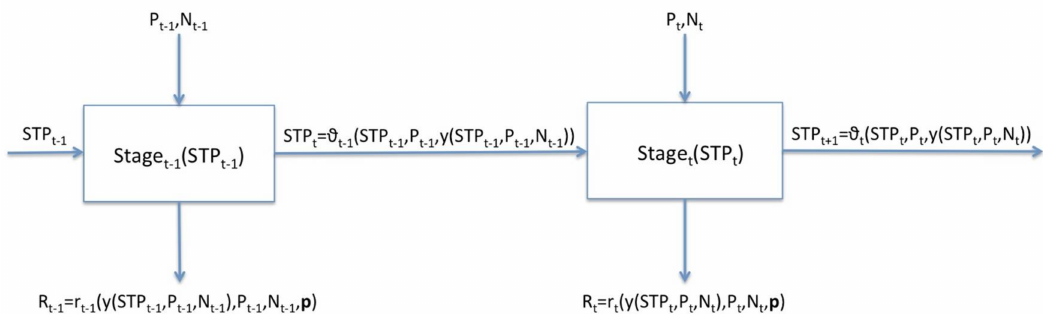
Figure 2. The conceptual farm-level dynamic decision model (adapted from Hardaker et al. [49]), where t denotes a stage (one year), STP is the soil test P, which is the state of the system, P and N denote annual input decisions, R denotes the annual state return, r is the stage return function, y is the annual crop yield, p denotes the prices of inputs and output, and ϑ denotes a transition function that determines the evolution of the system from one stage to the